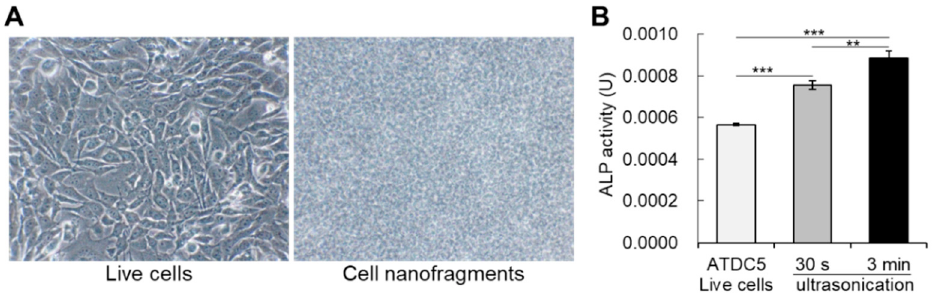
Figure 3. ( A ) Bright-field images of live cells (ATDC5 cells) on the left, and the cell nanofragments on the right side. ( B ) Graph shows the alkaline phosphatase enzymatic activity in live cells, as well as in the cell nanofragments immediately after cell disruption by ultrasonication for 30 s or 3 min. Note that cell disruption by ultrasonication increases the activity of alkaline phosphatases, and is significantly higher in the cell nanofragments obtained from ultrasonication 3 min. ** p ≤ 0.01 and *** p ≤ 0.001, ANOVA, Bonferroni post-hoc test.